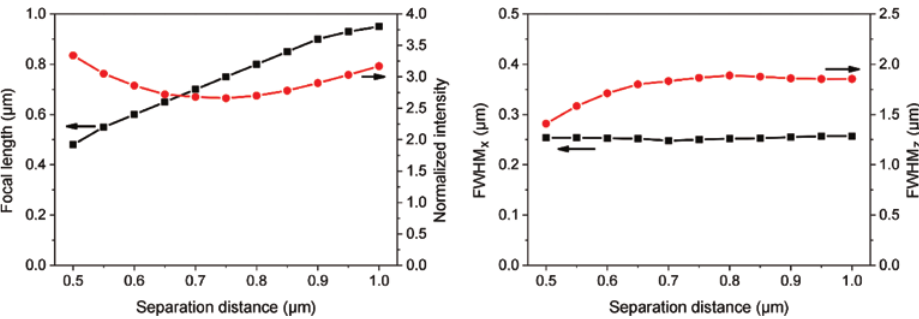
Figure 5: Evolution of optical characteristics with respect to the decrease of the separation distance below 1 μ m. Left: variations of focal lengths (black squares) and normalized maximum intensities (red circles) with the separation distance. Right: lateral resolution FWHM (black squares) and depth of focus FWHM (red circles) variations with the separating x z